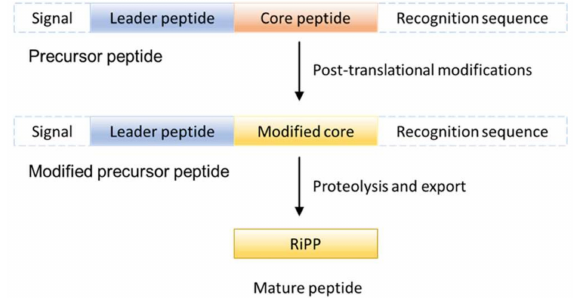
Figure 1. General Ribosomally synthesized and post-translationally modified peptide (RiPP) natural products biosynthetic pathway. Adapted from Reference